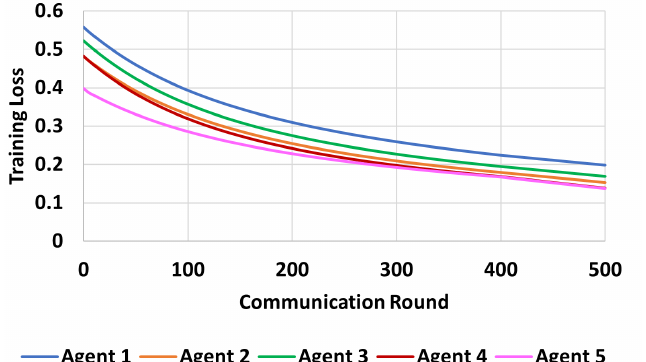
Figure 21. FedResilience’s impact on participating FL agents’ (five agents and three stragglers) model loss for the prediction of CIAs’ resource-sharing